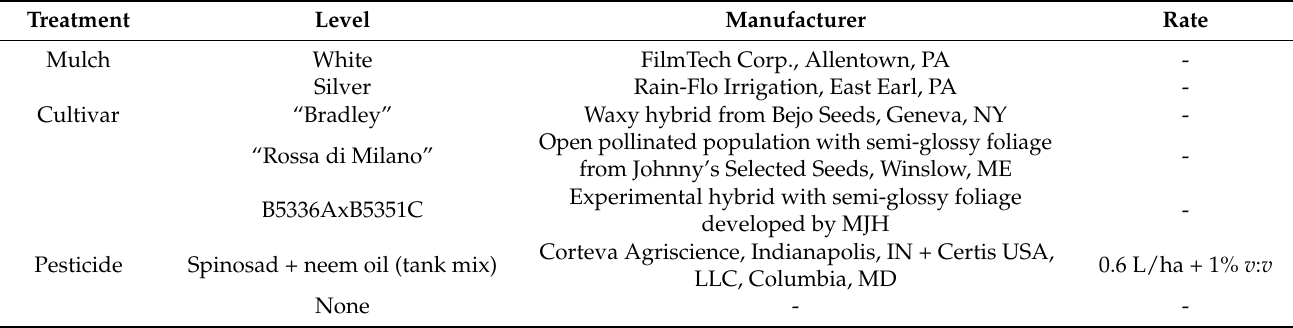
Table 1. Treatments evaluated in onion trials in 2018 and